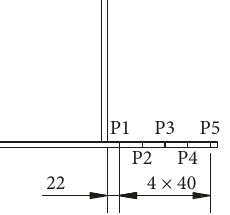
Figure 4: Pressure sensor arrangement.